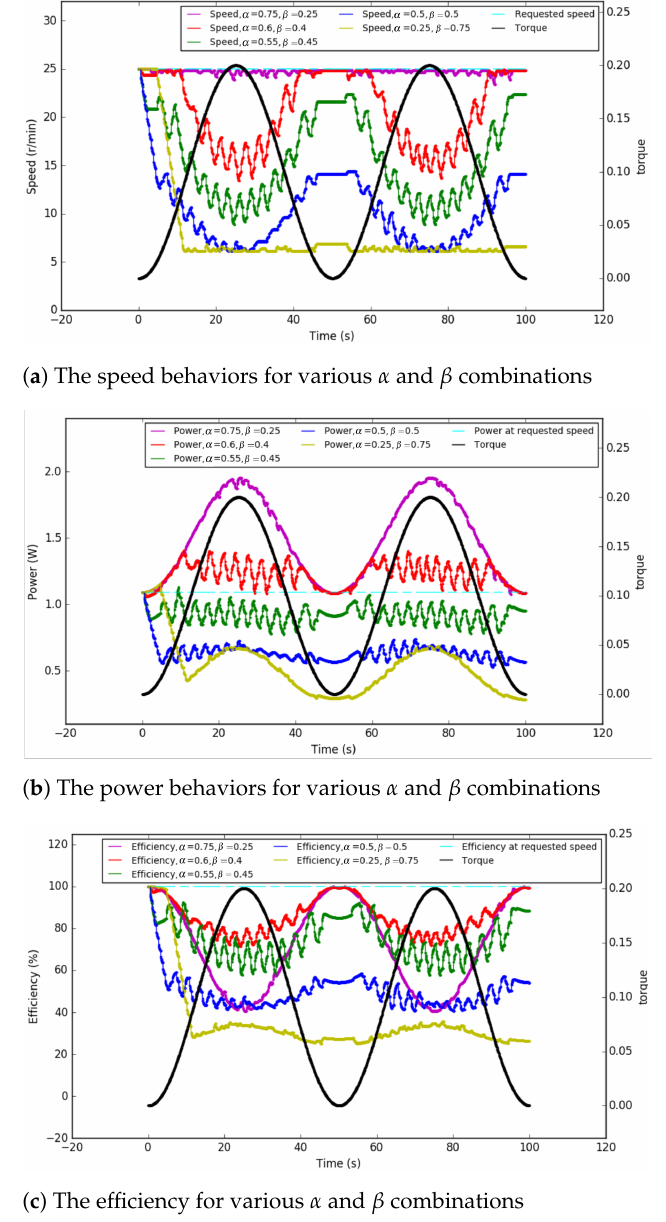
Figure 9. System behaviors for α and β combinations under an abnormal load